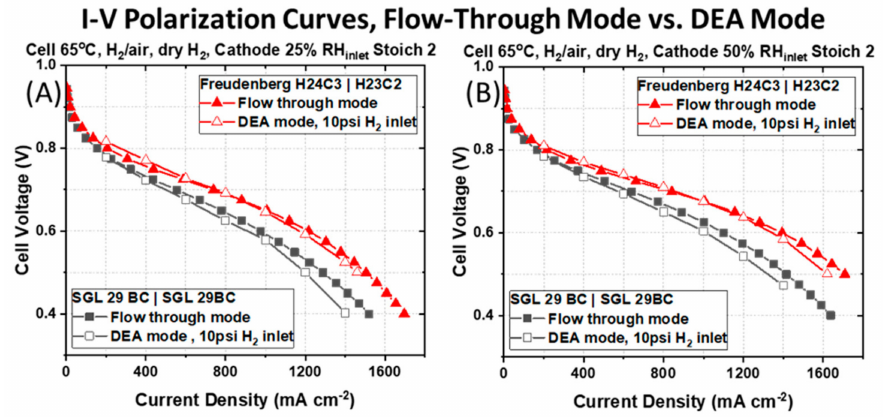
Figure 5. Galvanostatic I–V polarization curves measured for a PEMFC containing a typical symmetric pairing of SGL 29BC GDM on the anode and cathode side and a PEMFC containing an asymmetric pairing of Freudenberg GDM. Polarization curves are measured in DEA mode (open symbols) and flow-through mode (closed symbols) at ( A ) 25% RH inlet cathode and ( B ) 50% RH inlet cathode. In all cases, the cell temperature is 65 ◦ C, in H 2 | air, with air supplied to the cathode at stoichiometric ratio of 2 at atmospheric pressure. During DEA mode, dry H 2 is supplied to the anode at 2 psi. In flow-through mode, the inlet RH of the H 2 at the anode matches the cathode RH and H 2 flows at a stoichiometric ratio of